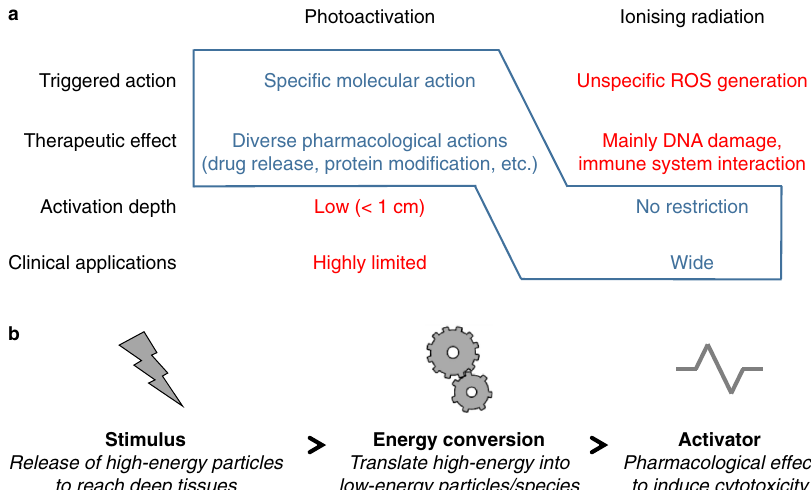
Fig. 1 Approach to tackle deep-tissue photoactivation to overcome the current limitation preventing wide clinical applications. a Highlight of advantages (blue) and limitations (red) of photoactivation and ionising radiation to exhibit the complementary properties of both domains which can be combined (blue delineation) for an original molecular-activation concept. b Our approach is based on using ionising-radiation stimulus to reach deep tissues and to bene fi t from local conversion of high-energy particles into low-energy particles and species suitable for molecular activation. In this way, speci fi c pharmacological actions could be induced in biological tissues without any depth